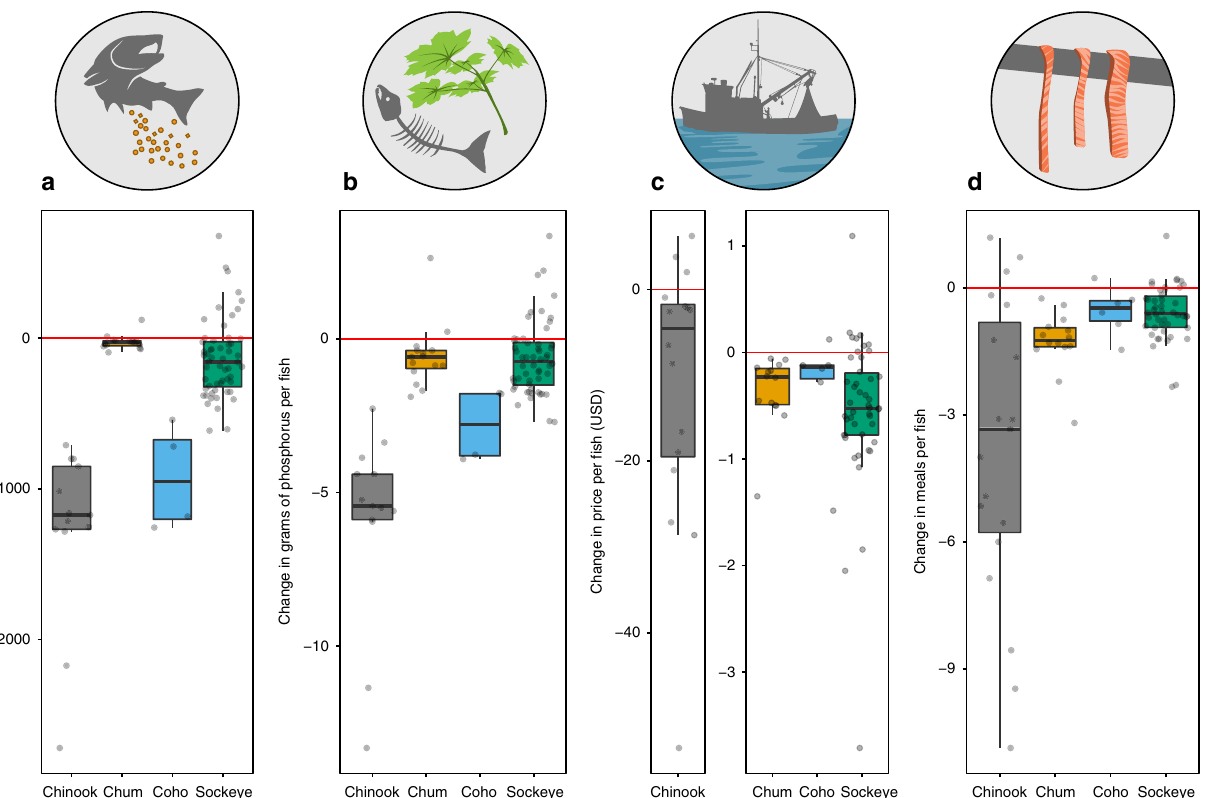
Fig. 5 Size declines could result in negative consequences for ecosystems and people. Salmon body size declines over the past 30 years have negative consequences for a fecundity, b nutrient transport, c commercial fi shery value, and d rural food security. We estimated the difference in ecosystem services provided by an average salmon before 1990 versus after 2010, by converting change in mass to change in services provided. A meal is the species- speci fi c average reported meal size in grams reported by subsistence users from two villages in nearby Yukon Territory, Canada, see Methods for details. Each gray point represents an estimate for an individual population. The red line represents no change in ecosystems services provided by each fi sh. Center line represents the median, box limits represent the upper and lower quantiles, whiskers represent the 1.5× interquartile range. Sample sizes are presented in Supplementary Data